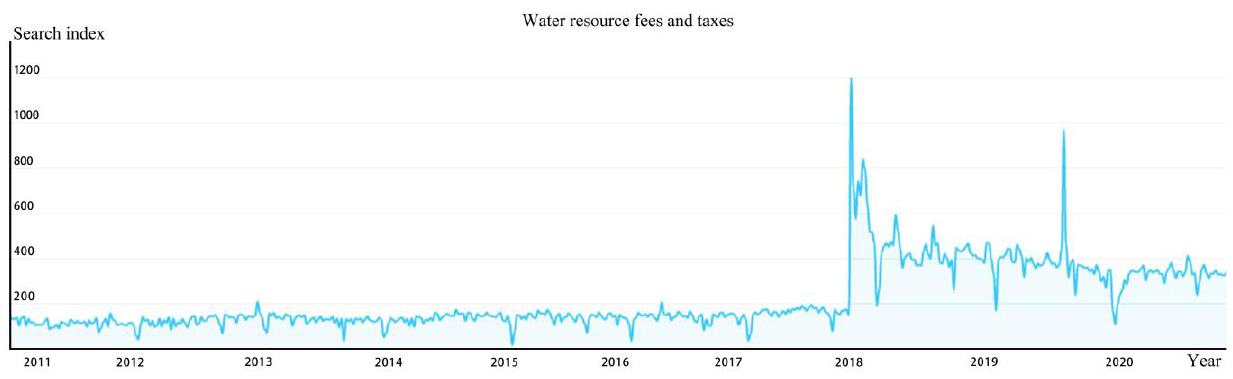
Figure 3. Baidu index trend of water-related keywords, 2011 – 2021.